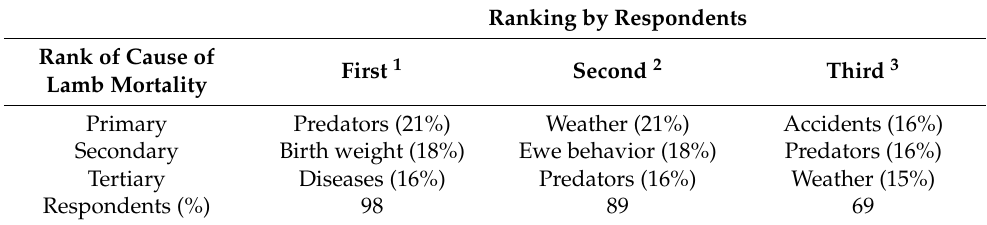
Table 4. Farmers’ perceptions of the main cause for live lamb mortality on their farms (%).